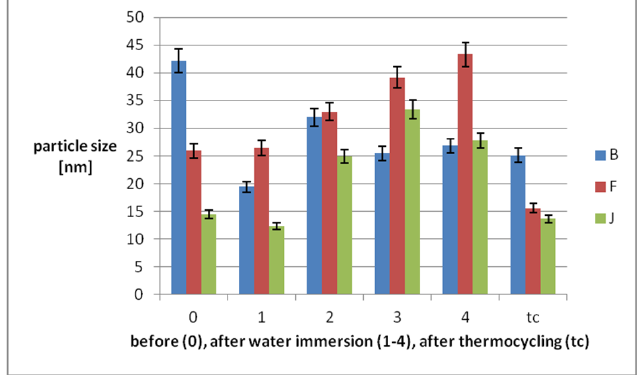
Figure 4. Mean particle size on the materials surfaces.